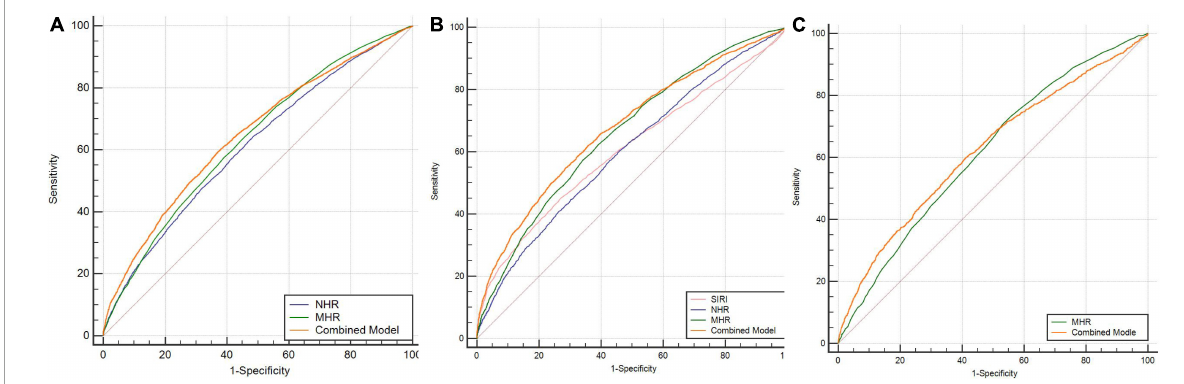
FIGURE2 (A) ROC curves for the diagnostic ability of the parameters for SCZ (SCZ vs. HCs). NHR: AUC 0.611 (95% CI = 0.604 to 0.618), P < 0.001; MHR: AUC 0.632 (95% CI = 0.625 to 0.639), P < 0.001; combined model: AUC 0.647 (95% CI = 0.639 to 0.655), P < 0.001. (B) ROC curves for the diagnostic ability of the parameters for BD-M (BD-M vs. HCs). SIRI: AUC 0.608 (95% CI = 0.598 to 0.618), P < 0.001; NHR: AUC 0.603 (95% CI = 0.593 to 0.612), P < 0.001; MHR: AUC 0.661 (95% CI = 0.651 to 0.670), P < 0.001; combined model: AUC 0.677 (95% CI = 0.668 to 0.686), P < 0.001. (C) ROC curves for the diagnostic ability of the parameters for BD-D (BD-D vs. HCs). MHR: AUC 0.615 (95% CI = 0.606 to 0.626), P < 0.001; combined model: AUC 0.623 (95% CI = 0.612 to 0.634), P < 0.001. SCZ, schizophrenia; BD-M, bipolar disorder manic episodes; BD-D, bipolar disorder depressive episodes; HCs: healthy